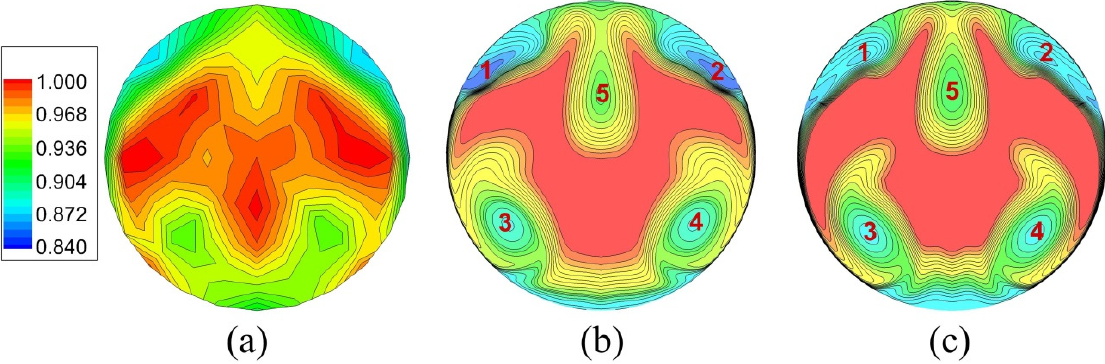
Figure 8. Comparison of the total pressure contours at the AIP between ( a ) the experiment, ( b ) the current OpenFOAM solver, and ( c ) the previous Fluent solver [33] at M = 0.7 and p AIP / p 0 = 1.18.